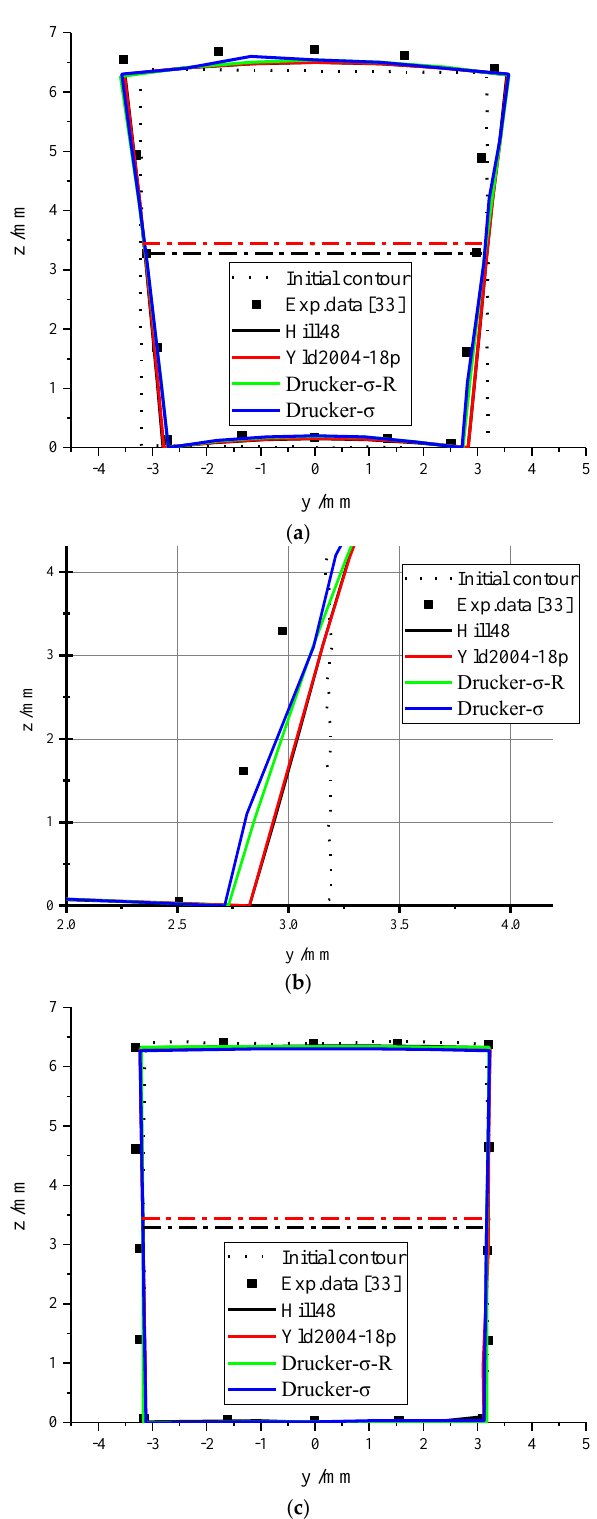
Figure 17. Comparisons of the experimentally obtained y – z cross section of the Zirconium bent beams (black dots) versus the numerical predictions of Hill’s 48, Yld2004-18p, and two extended Drucker models: ( a ) TTB case, ( b ) local enlarged zone of TTB and ( c ) IPB case (black dash-dot lines represent beam mid-surface for yield functions not considering strength di ff erential e ff ect (SDE), while the red implies shift of mid-surface for yield functions considering